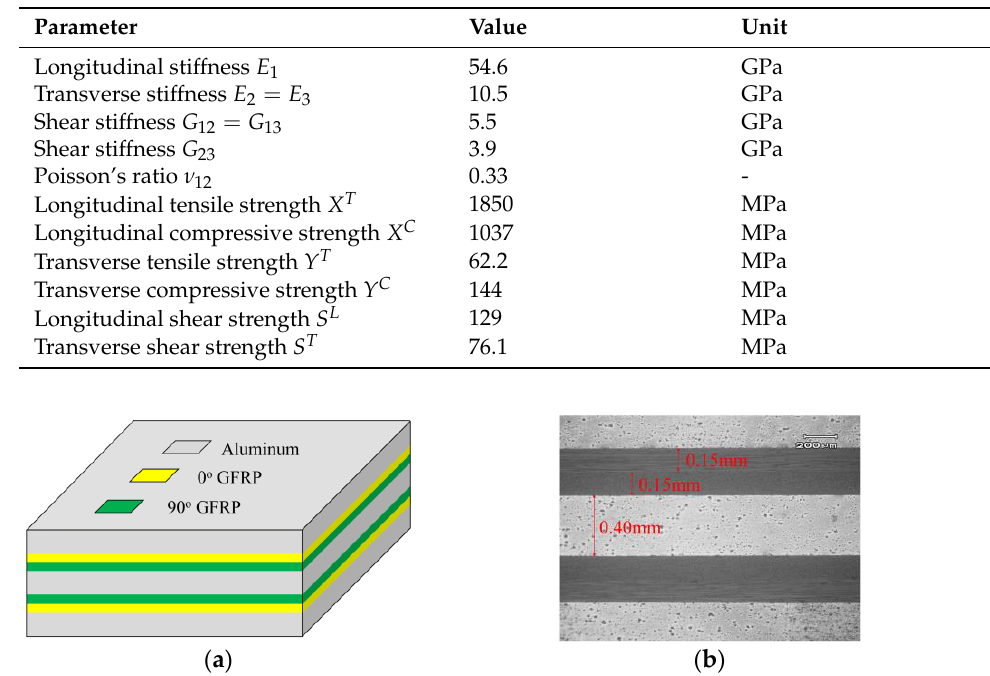
Table 3. Mechanical properties of unidirectional GFRP laminate [21].